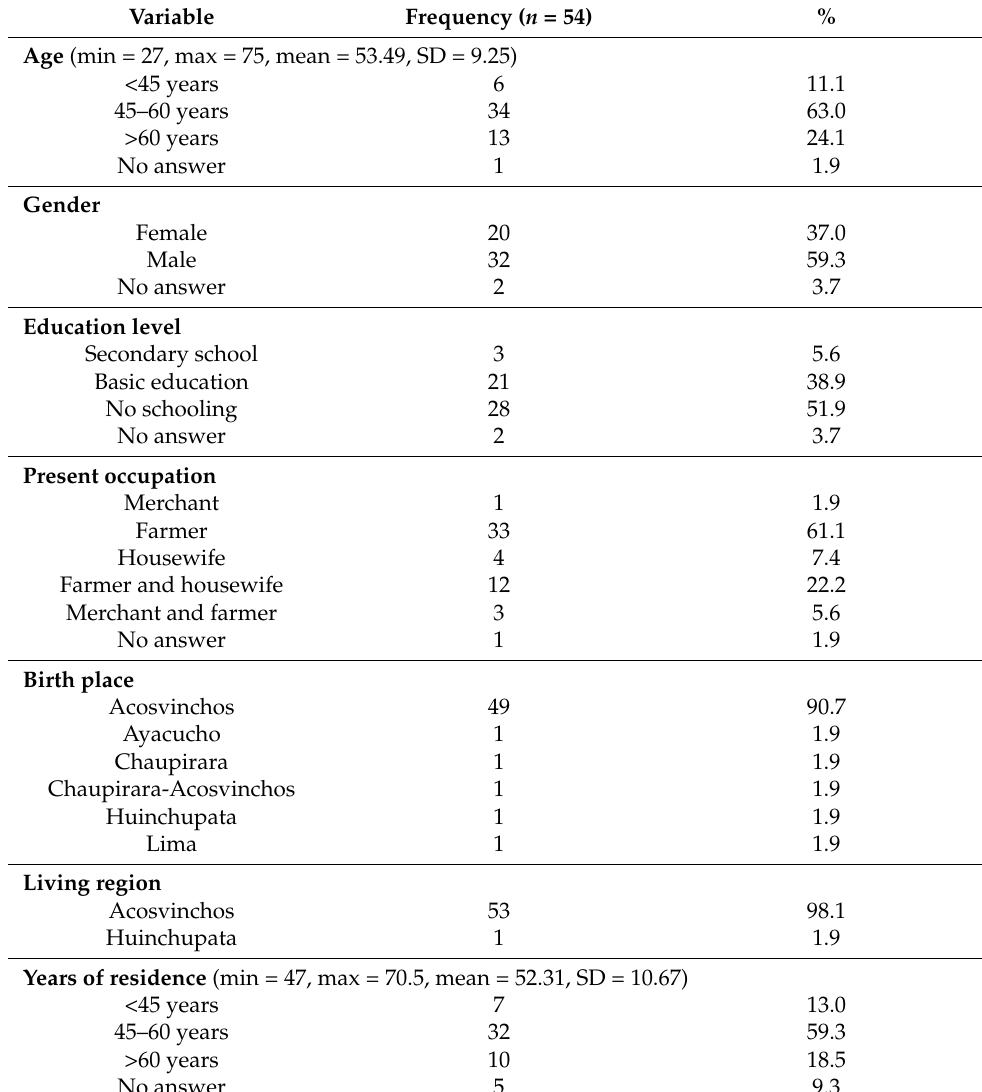
Table 2. Socio-economic profile of the inhabitants surveyed in Acos